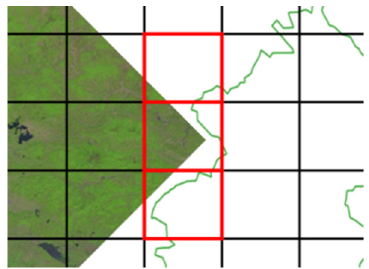
Figure 13. Problems of spatial query based on Hilbert grids.